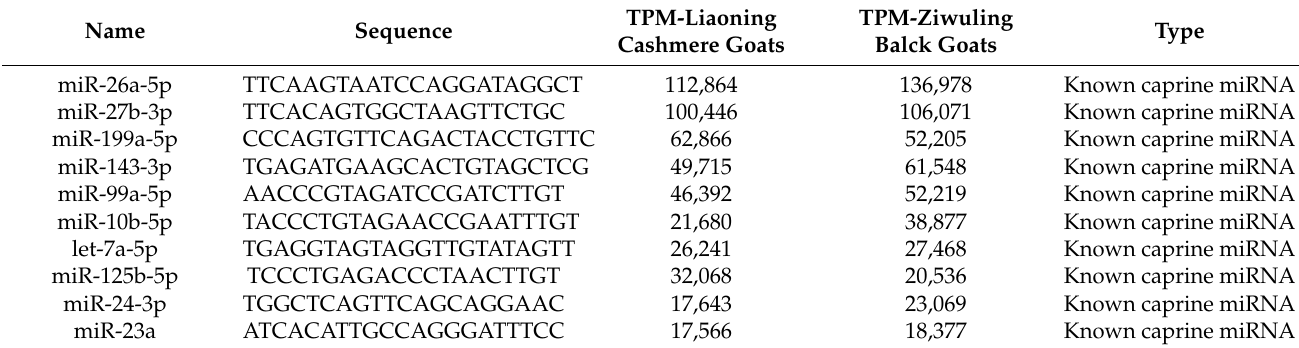
Table 1. The top ten most expressed miRNAs.